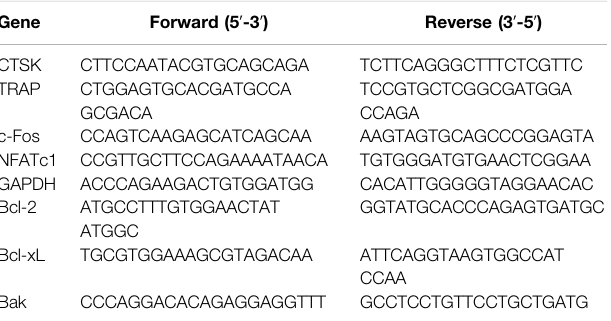
TABLE 1 | Sequences of both the forward and reverse primers of mRNAs in RT-PCR. Gene Forward (5 ʹ -3 ʹ